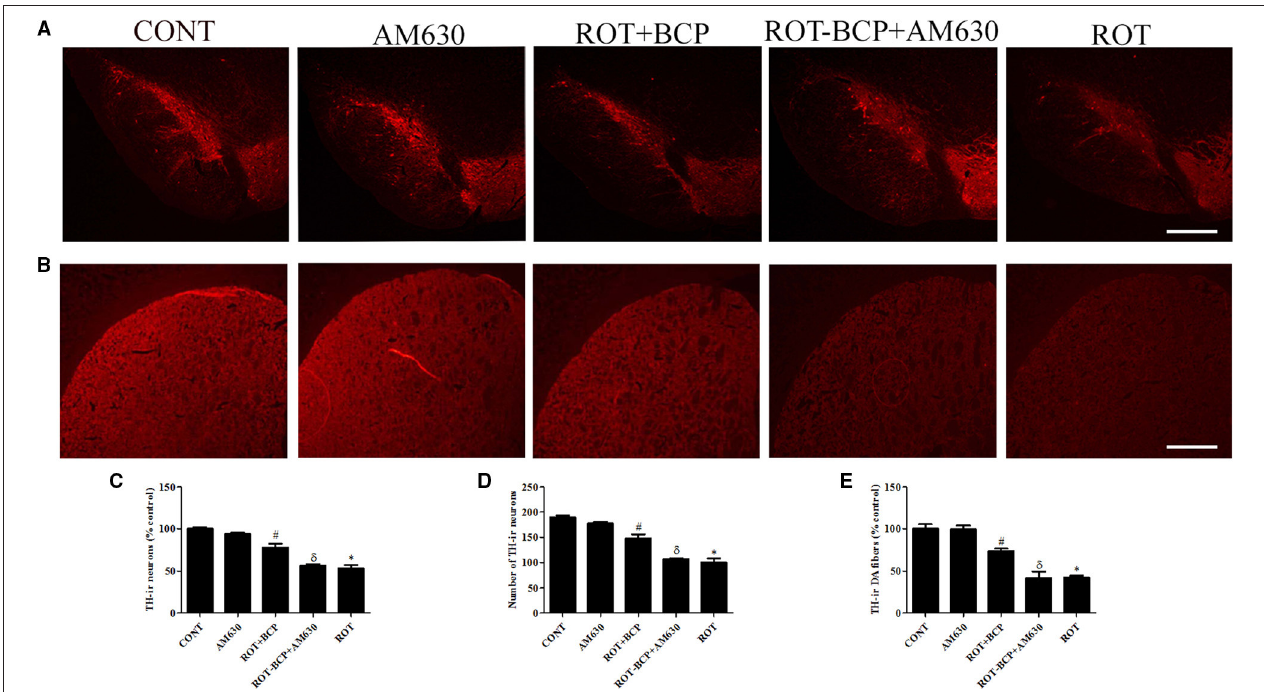
FIGURE 3 | The immunohistochemistry for tyrosine hydroxylase (TH) to detect the expression of the TH-immunoreactive (TH-ir) dopaminergic (DA) neurons in the substantia nigra pars compacta (SNpc) and the TH-ir dopamine nerve fibers in the striatum. Values are expressed as percent mean ± SEM ( n = 3). The scale bar is 100 µ m. (A) The number of TH-ir neurons was decreased in the SNpc of ROT-injected rats as compared to control (CONT) group. While, BCP supplementation leads to increased expression of TH-ir neurons in ROT + BCP group as compared to ROT group. Furthermore, the ROT-BCP + AM630 group showed decreased expression of TH-ir neurons as compared to ROT + BCP group. (B) Similarly, TH-ir DA nerve fibers immunofluorescence was also decreased in the ROT group in comparison to the CONT group rats. Moreover, BCP supplementation increased the immunoreactivity of DA fibers as compared to ROT group. The ROT-BCP + AM630 group showed TH-ir DA fibers expression similar to ROT group. (C,D) The number of TH-ir DA neurons in the SNpc was counted from each group. A significant (* p < 0.05) decrease in the number of DA neurons was observed in the SNpc of the ROT group when compared to the CONT group. BCP treatment to ROT administered rats significantly (# p < 0.05) protected the DA neurons from the ROT-induced neuronal death in the ROT + BCP group. The ROT-BCP + AM630 group also showed significantly ( δ p < 0.05) decreased number of DA neurons as compared to the ROT + BCP group. No significant differences were observed between the DA neurons of the CONT and AM630-only group. (E) Immunofluorescence of the TH-ir DA fibers was observed in the striatum of different groups. Significant (* p < 0.05) decrease in the TH-ir striatal DA fibers was observed in the ROT group as compared to the CONT group. Although, BCP supplementation of ROT treated rats significantly (# p < 0.05) inhibited the loss of the TH-ir DA fibers in the ROT + BCP group as compared to the ROT group. ROT-BCP + AM630 group showed significant ( δ p < 0.05) loss of the TH-ir DA fibers when compared to the ROT + BCP group. CONT and AM630-only group did not show any apparent loss of TH-ir DA